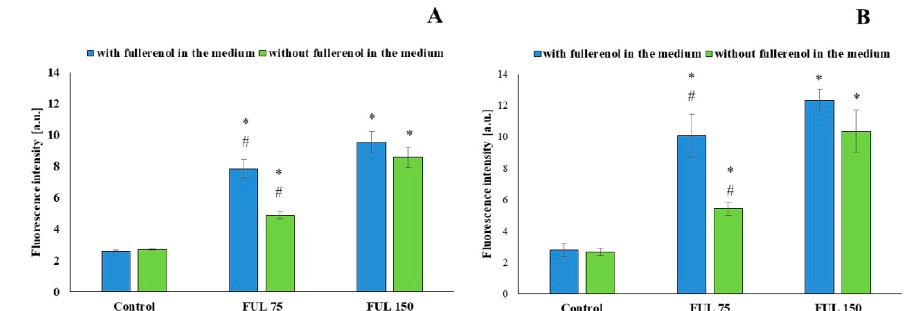
Figure 5. Fluorescence of fullerenol NPs inside PBMCs after 24 h ( A ) and 48 h ( B ) of incubation with fullerenol (37 °C, 5% CO 2 atmosphere, 100% relative humidity). Blue bars—fullerenol was not washed out, green bars—fullerenol was washed out. Asterisks are used to mark values that are statistically different in comparison with control values (* p < 0.05), hashes—values that are statistically different in comparison with samples containing fullerenol at the concentration of 150 mg/L (# p < 0.05). All experiments were repeated 10–12 times.